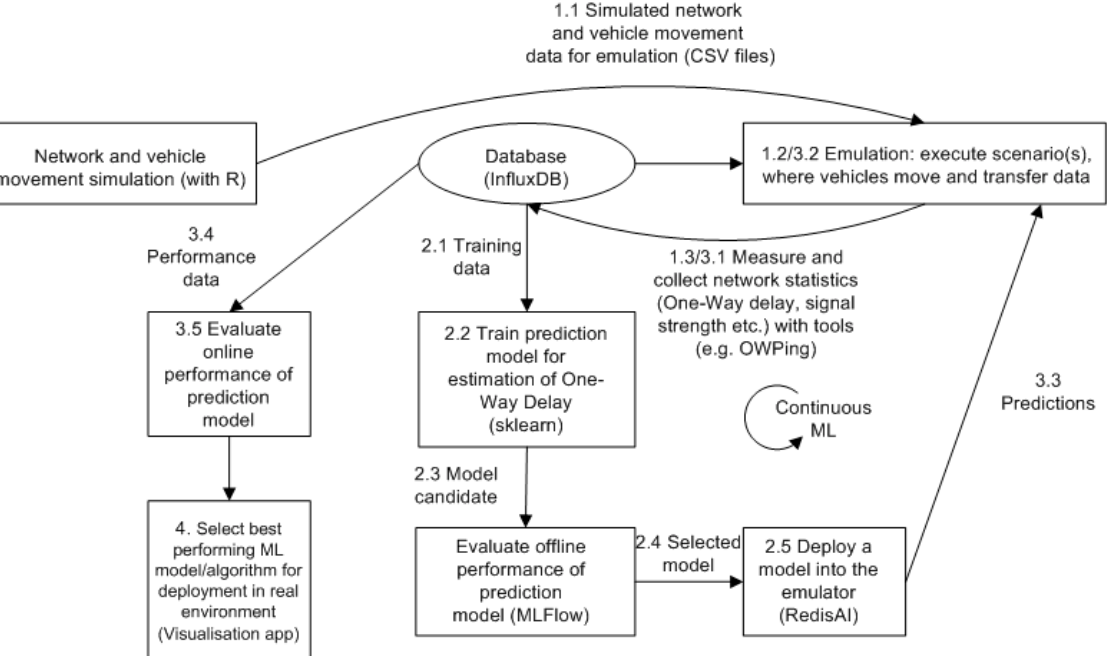
Figure 2. Conceptual view of research artifacts for enabling multi-access routing for moving vehicles based on continuous ML in emulation environments. In the view, rectangles illustrate functionalities, ellipsis describes data stores, and arrows depict data